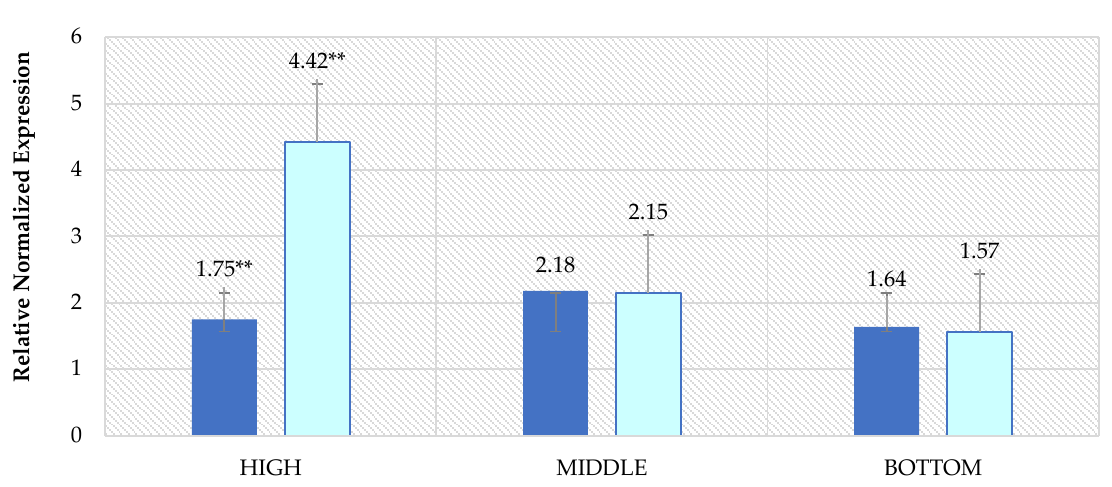
Figure 3. Level of relative normalized expression (RNE) of Firmicutes depending on the cage setting. ** p = 0.00427.